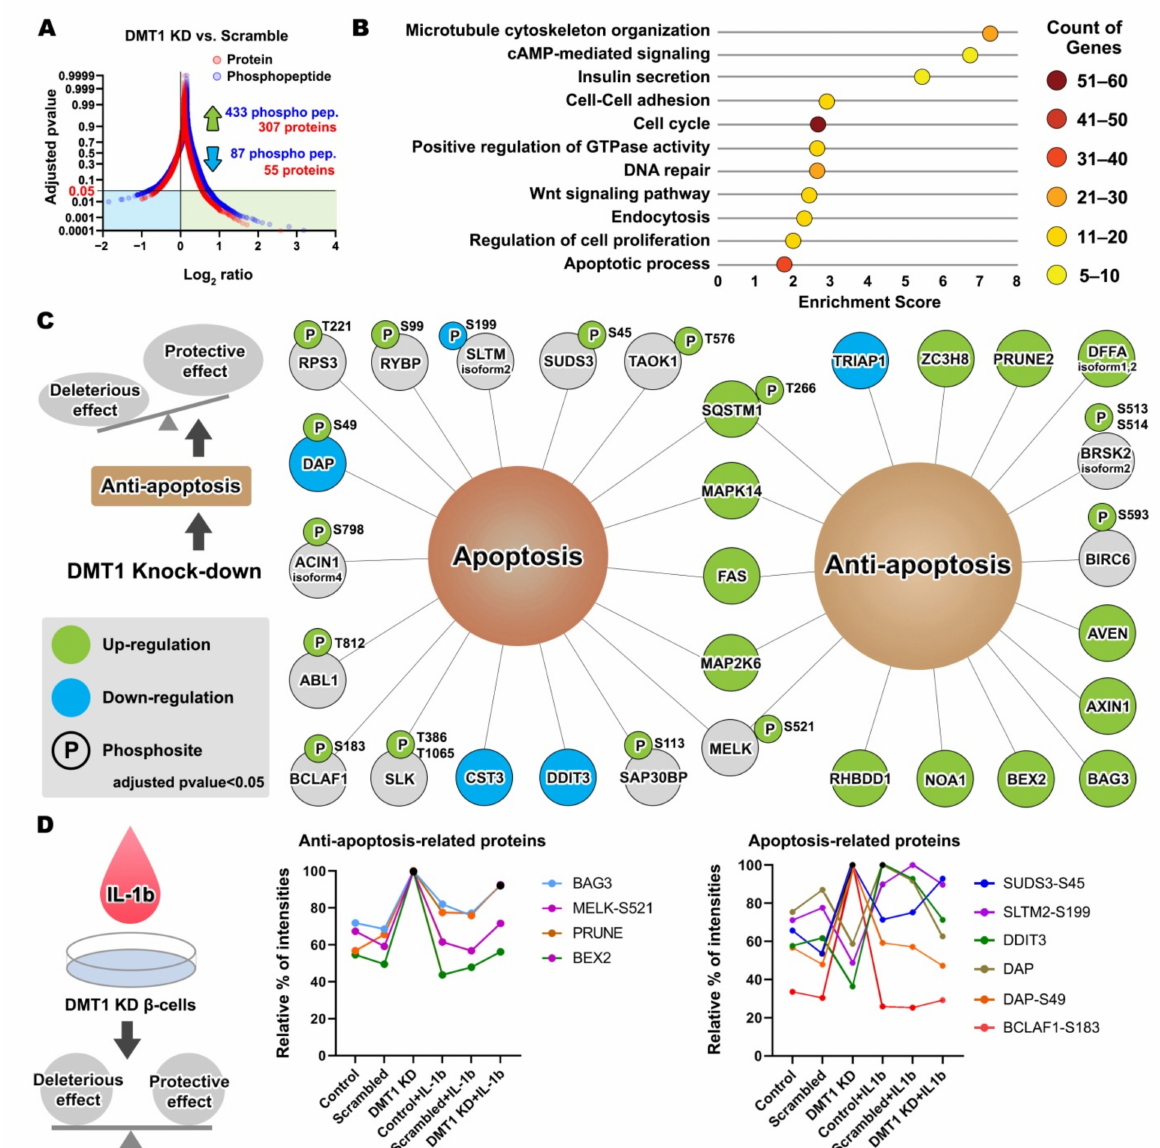
Figure 3. DMT1 knock-down-mediated anti-apoptosis signaling and potential protective effect ( A ) Plot chart showing the increased 307 proteins and 433 phosphopeptides and decreased 55 proteins and 87 phosphopeptides in the comparison of DMT1 -KD and SC. (adjusted p -value < 0.05) ( B ) Enriched biological processes for significantly regulated proteins and protein phosphorylation in the comparison of DMT1 -KD and SC. DAVID Gene Ontology enrichment analysis showing the fold enrichment score for the indicated dots ( x -axis) as well as the number of proteins assigned to classified functions (colors on circle). Corrected p -value < 0.05. ( C ) The relationship of the DMT1 knock-down-mediated proteins and protein phosphorylation in the apoptosis and anti-apoptosis. P, phosphosite. (green: up-regulation, blue: down-regulation, grey: not significantly regulated) ( D ) The balance of protective effect and deleterious effect in the IL-1 β exposed DMT1 knock-down β -cells. Anti-apoptosis-related proteins/phospho proteins ( left ). Apoptosis-related proteins/phospho proteins ( right